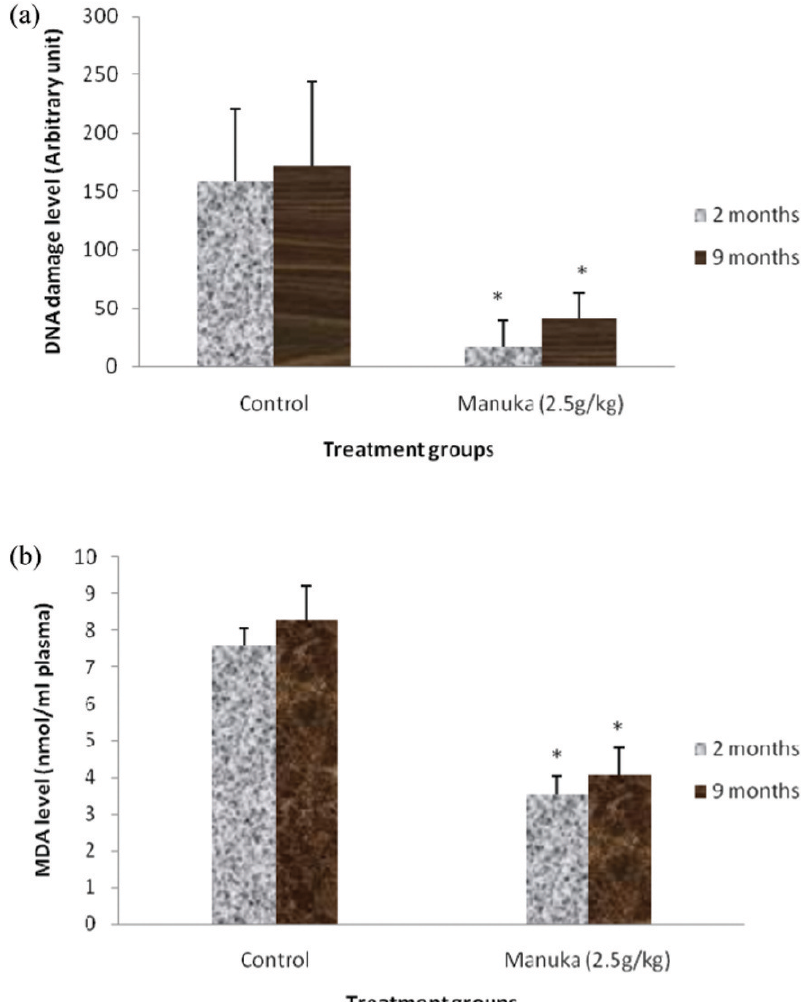
Figure 2 - Effect of manuka honey supplementation on the A) DNA damage and B) MDA levels of the young (2 months) and middle- aged (9 months) groups. The data are expressed as the means ¡ SD for 6 animals. * indicates a significant difference compared with the control group ( p